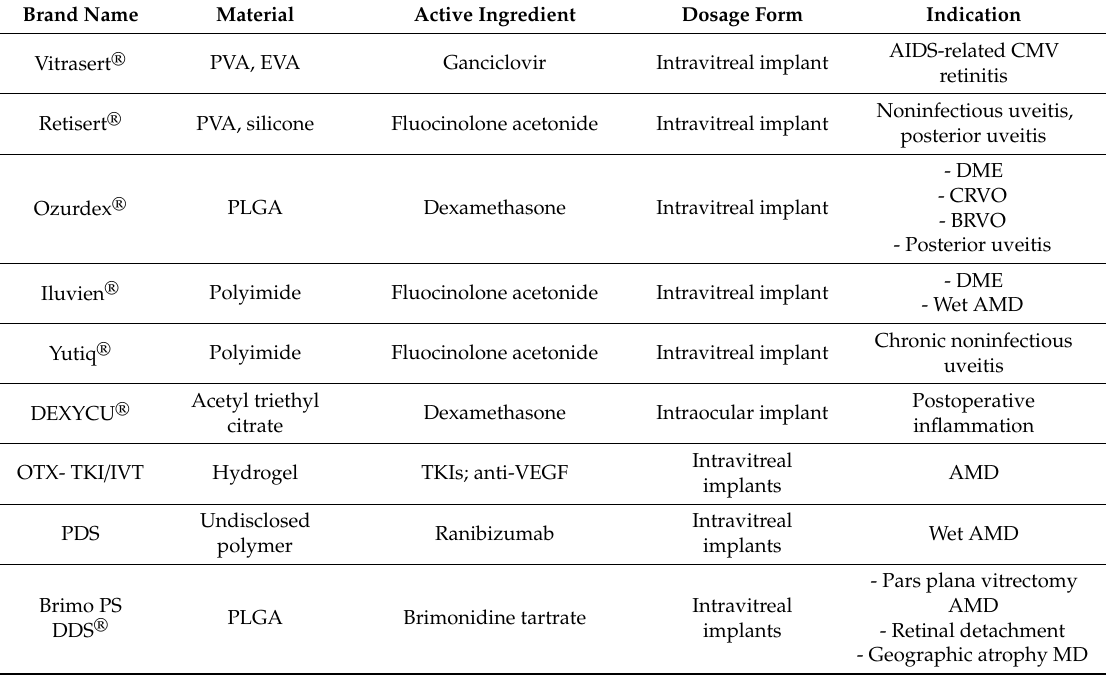
Table 2. A short list of ocular drug delivery implants in clinical trials (from a market survey performed in June